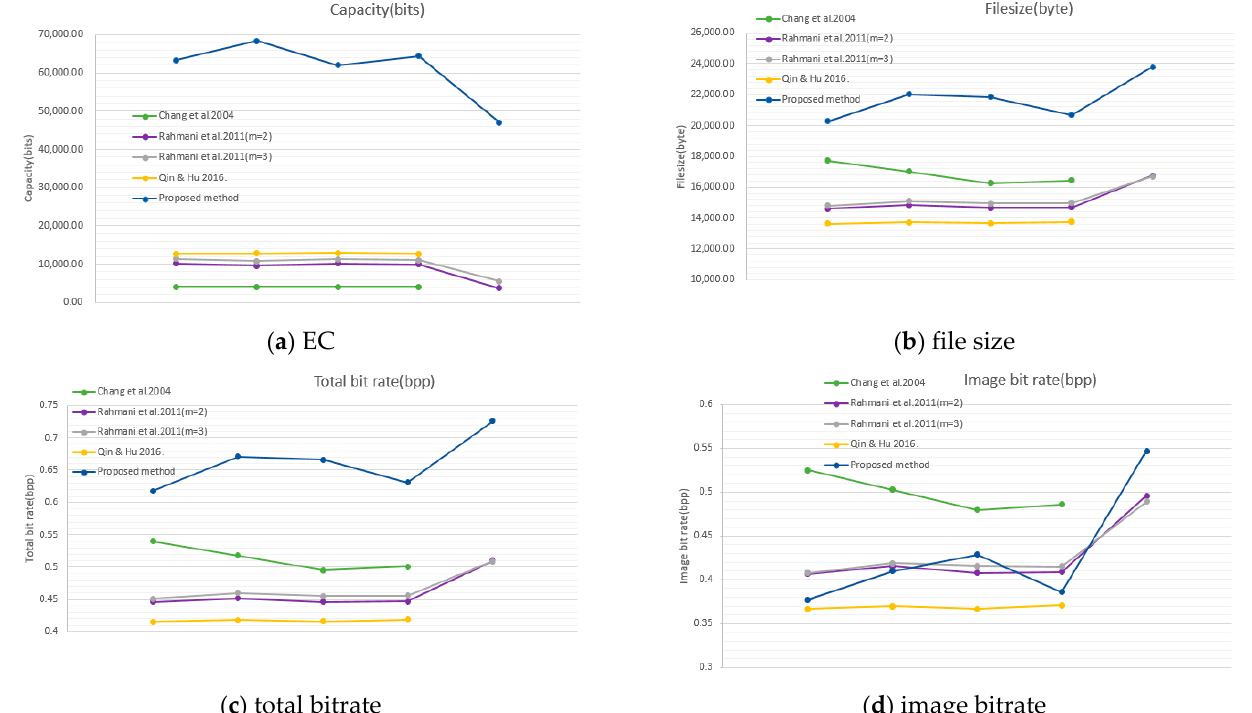
Figure 20. Comparisons with SOC-based RDH schemes. EC ( a ), file size ( b ), total bitrate ( c ), image bitrate ( d ). Table 7. Comparisons of EC and file size with SOC-based schemes.